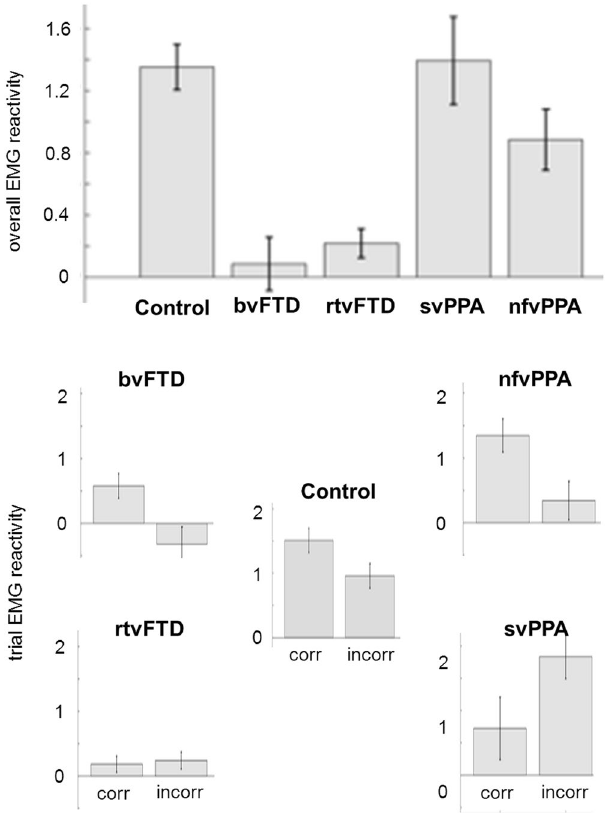
Figure 2. EMG reactivity in each participant group, and the relationship with identification accuracy. For each participant group, the histograms show mean overall facial muscle EMG reactivity (top) and EMG reactivity separately (below) for those trials on which viewed emotional expressions were identified correctly (corr) versus incorrectly (incorr); error bars indicate standard error of the mean (see also Table 2). bvFTD, patient group with behavioural variant frontotemporal dementia; Control, healthy control group; nfvPPA, patient group with nonfluent variant primary progressive aphasia; rtvFTD, patient subgroup with right temporal variant frontotemporal dementia; svPPA, patient group with semantic variant primary progressive